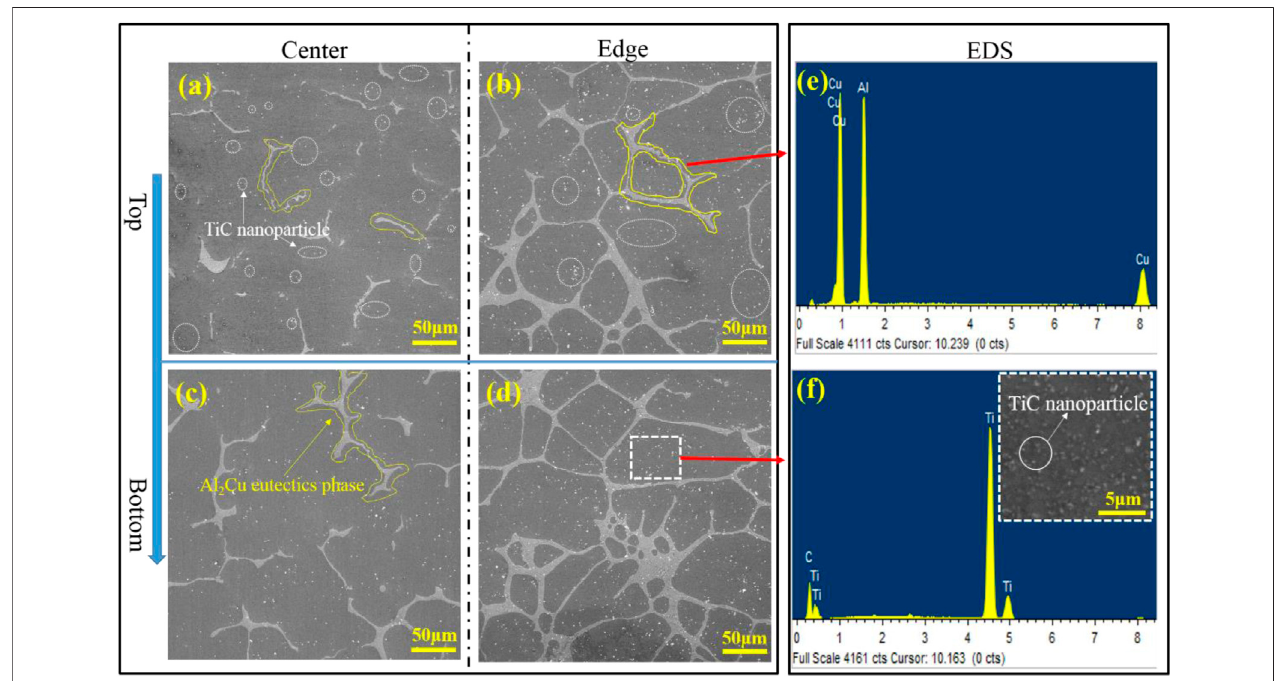
FIGURE7 | SEMmicrographs of theTiC/2219 nanocomposite at the (A) upper center, (B) upper edge, (C) lower center, and (D) lower edge positions. (E, F) EDS results identifying the chemical compositions of Al 2 Cu phases and TiC nanoparticles.